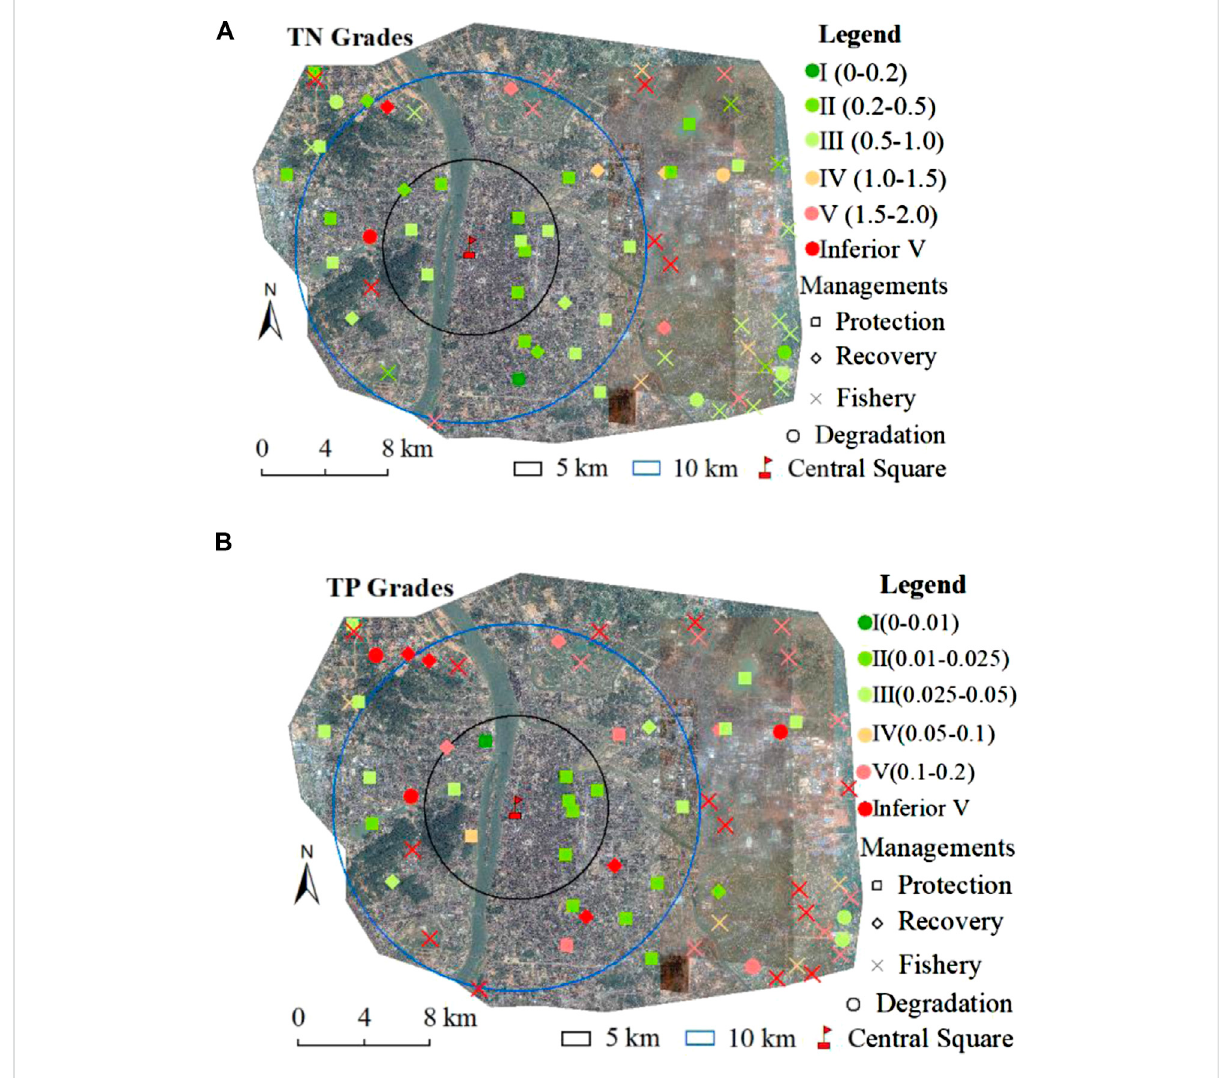
FIGURE 3 Classi fi cation levels of (A) TN and (B) TP in each sampled small water